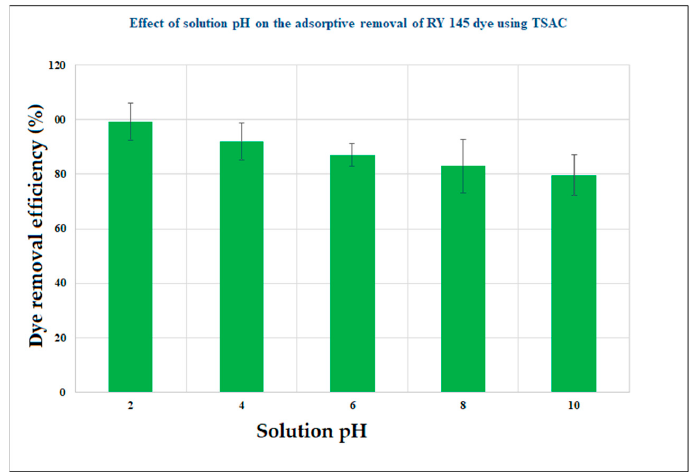
Figure 12. Effect of solution pH on the removal of RY 145 dye ([RY 145 dye] = 0.3 g/L dye; Adsorbent dose = 0.3 g/L of solution; contact time = 120 min).